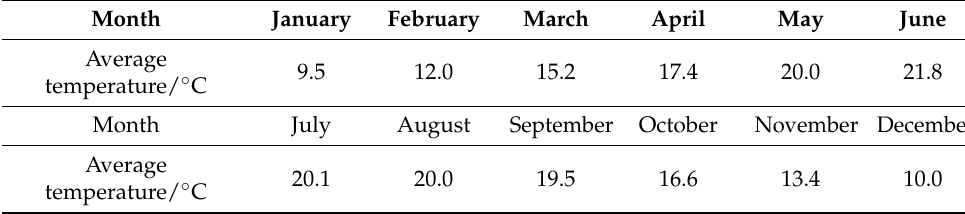
Table 2. The average monthly temperature of the project area for many